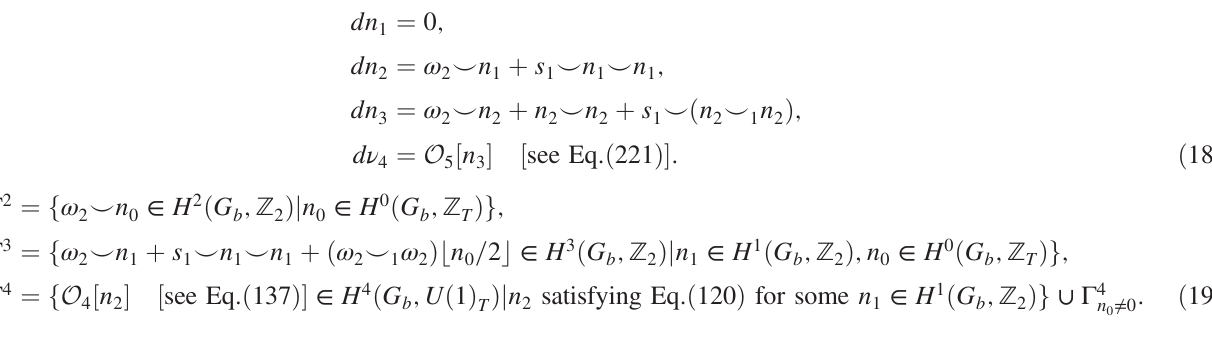
in different spatial f